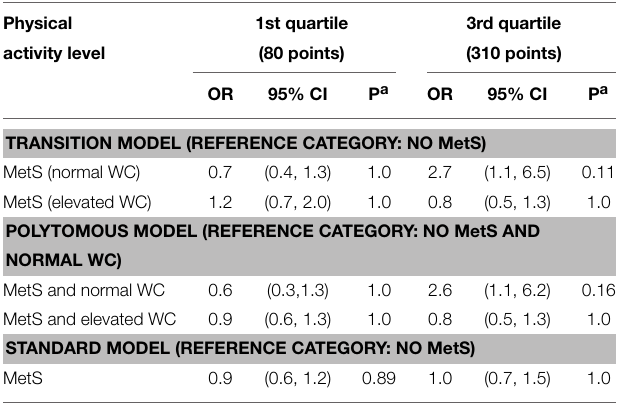
TABLE 4 | Association of the A allele of rs1375713 with metabolic syndrome depending on the level of moderate to strenuous physical activity and abdominal obesity status [normal or elevated waist circumference